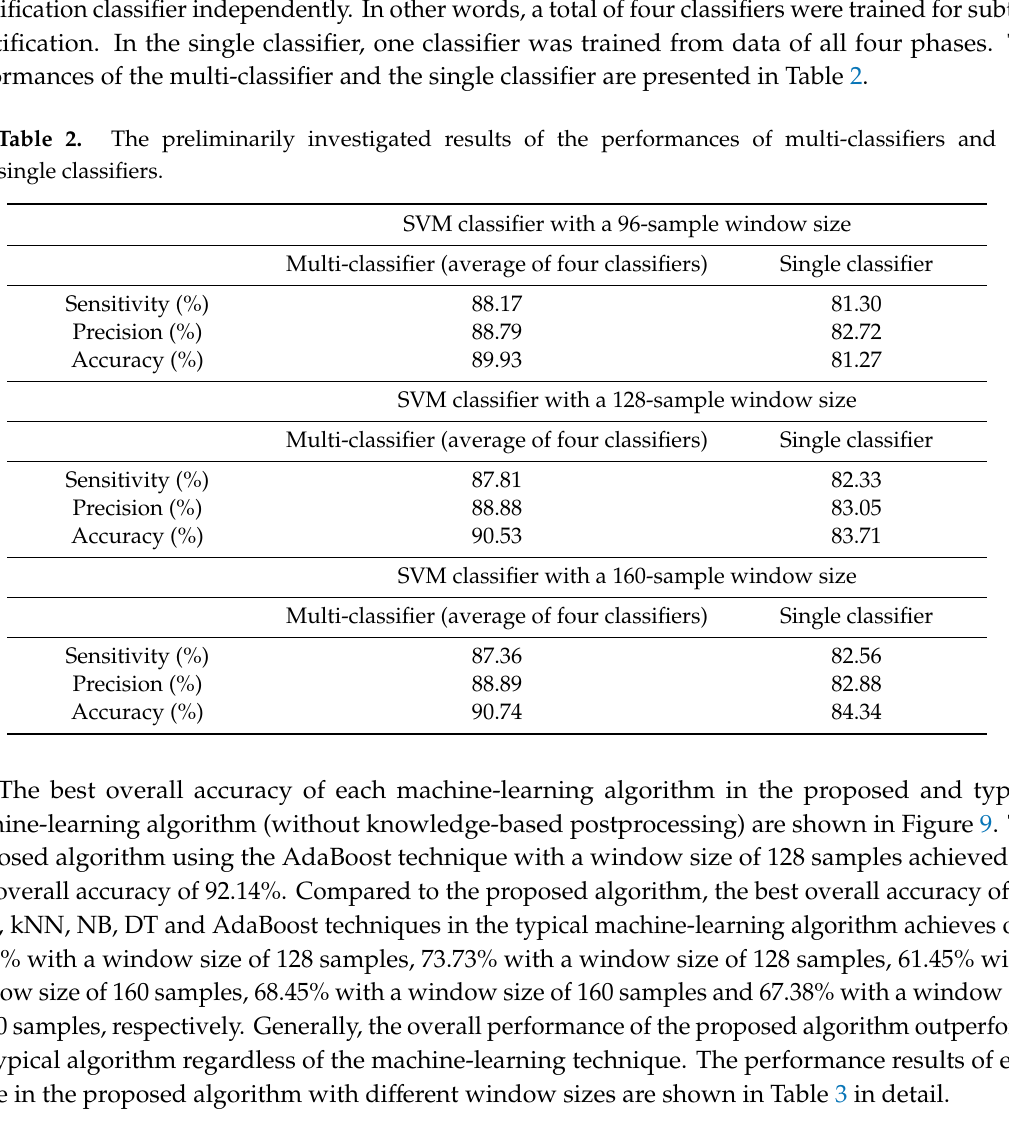
Table 3. The performance results of each phase in subtask identification system with window sizes of 96, 128, and 160